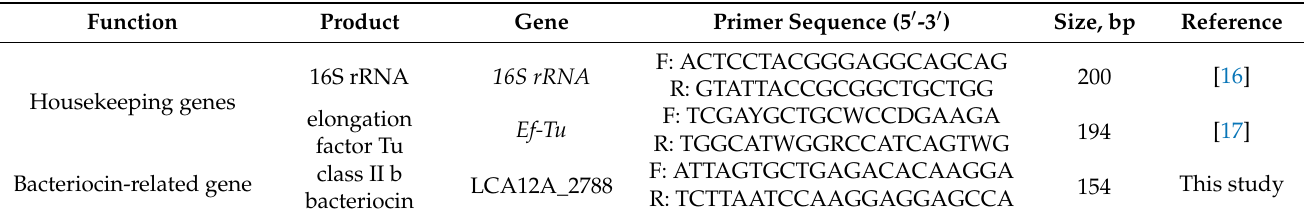
Table 3. Primers used in bacteriocin genes expression